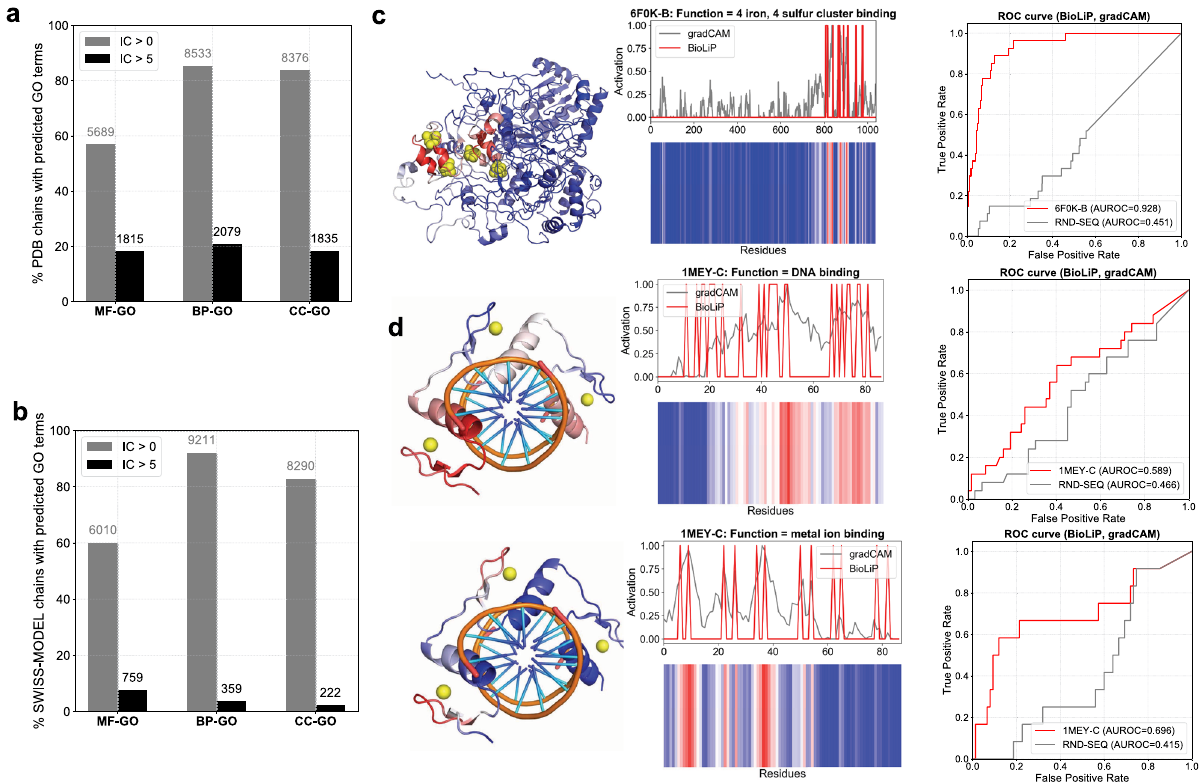
Fig. 6 Predicting and mapping function to unannotated PDB & SWISS-MODEL chains. Percentage/number of PDB chains ( a ) and SWISS-MODEL chains ( b ) with MF-, BP-, and CC-GO terms predicted by our method; the number of speci fi c GO term predictions (with IC >5) are shown in blue and red for PDB and SWISS-MODEL chains, respectively. c An example of a Fe – S-cluster-containing hydrogenase (PDB Id: 6F0K), found in Rhodothermus marinus, with missing GO term annotations in SIFTS (unannotated). The PDB chain lacks annotations in databases used for training our model and DeepFRI predicts to bind a 4Fe – 4S iron – sulfur cluster with high con fi dence score. The predicted grad-CAM pro fi le signi fi cantly overlaps with ligand-binding sites of 4Fe – 4S obtained from BioLiP, as shown by the ROC curve. d grad-CAM pro fi les for predicted DNA binding and metal ion binding functions mapped onto the structure of an unannotated zinc fi nger protein (PDB Id: 1MEY) found in Escherichia coli; the corresponding ROC curves show signi fi cant overlap between the grad-CAM pro fi le and the binding sites obtained from